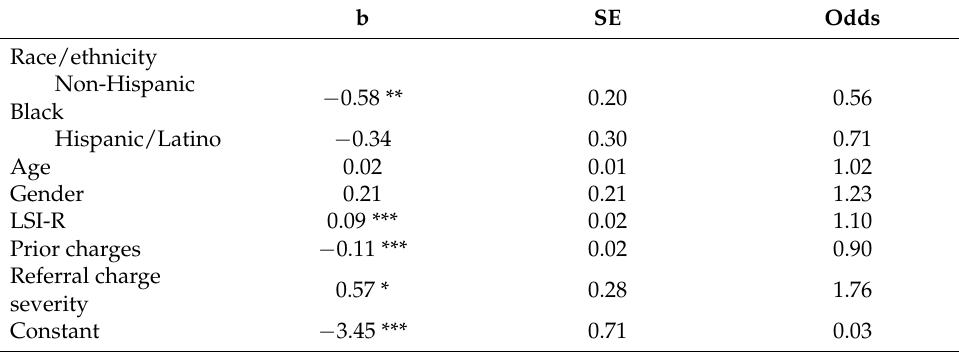
Table 2. Logistic Regression Results for the Likelihood of Admission ( N =